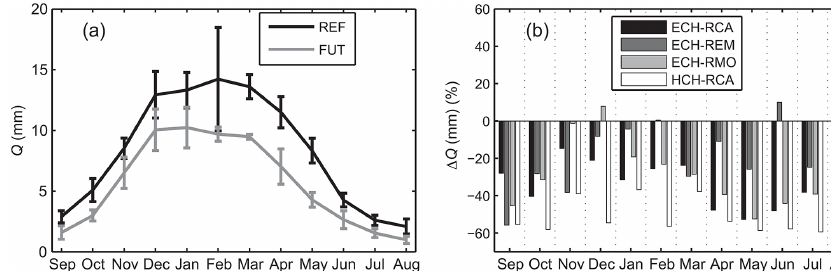
Figure 6. Same as Fig. 4, but for the mean monthly Q at the RMB outlet.